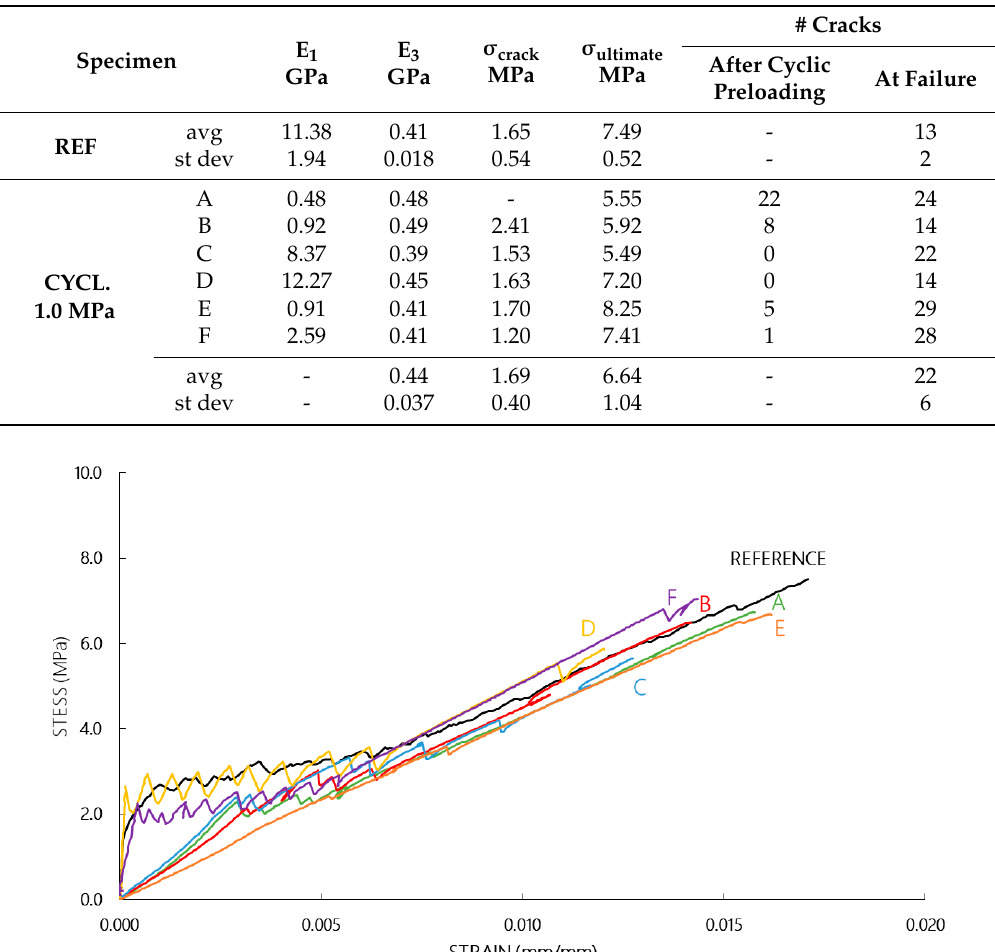
Table 7. Quantitative comparison of some distinctive parameters of the static tensile stress–strain curve: the average reference versus the specimens cyclically preloaded to 1.0 MPa. Specimen